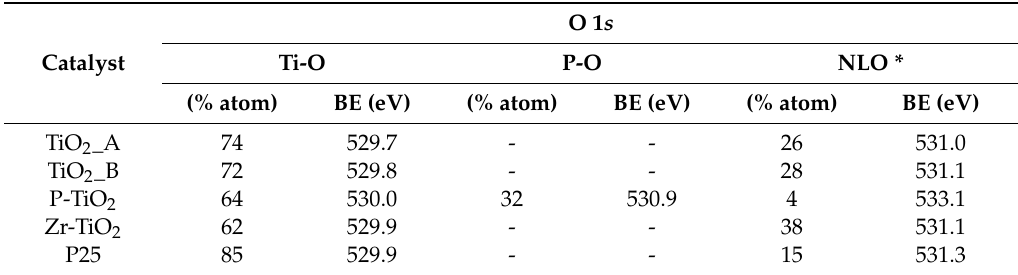
Table 6. Relative abundances of O species (in atomic percentage) derived from deconvoluted O 1 s XP spectra.